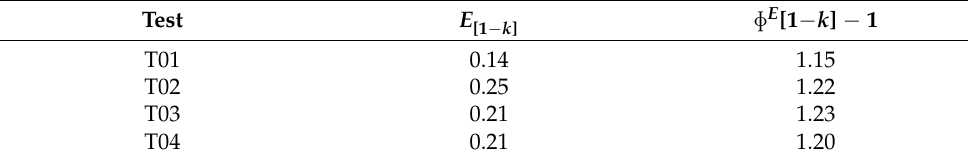
Table 6. Relation of minimum and F when ANN